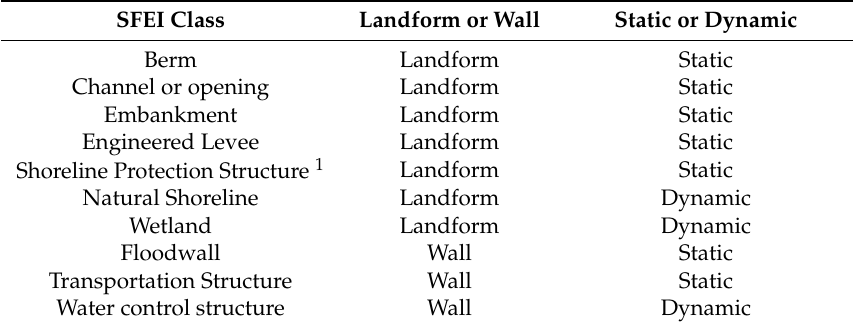
Table 2. Reclassification scheme used to match SFEI data to our analysis framework.